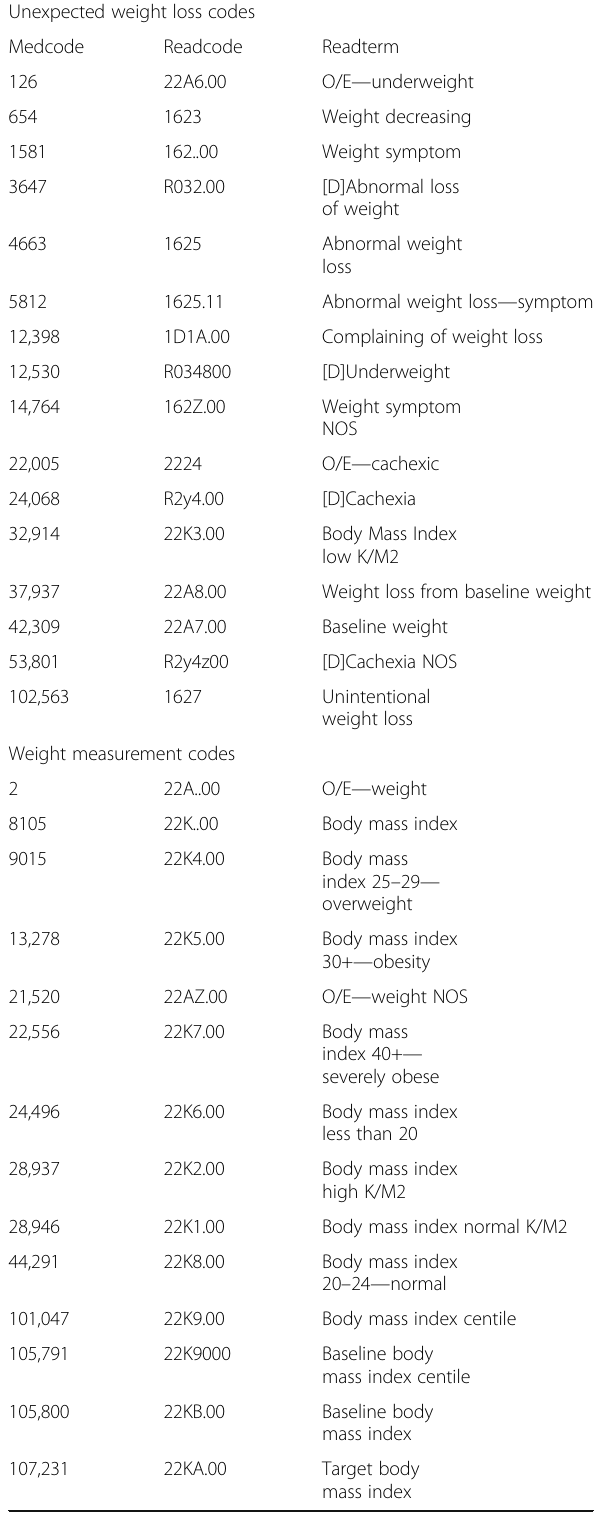
Table 1 Weight measurement and unexpected weight loss